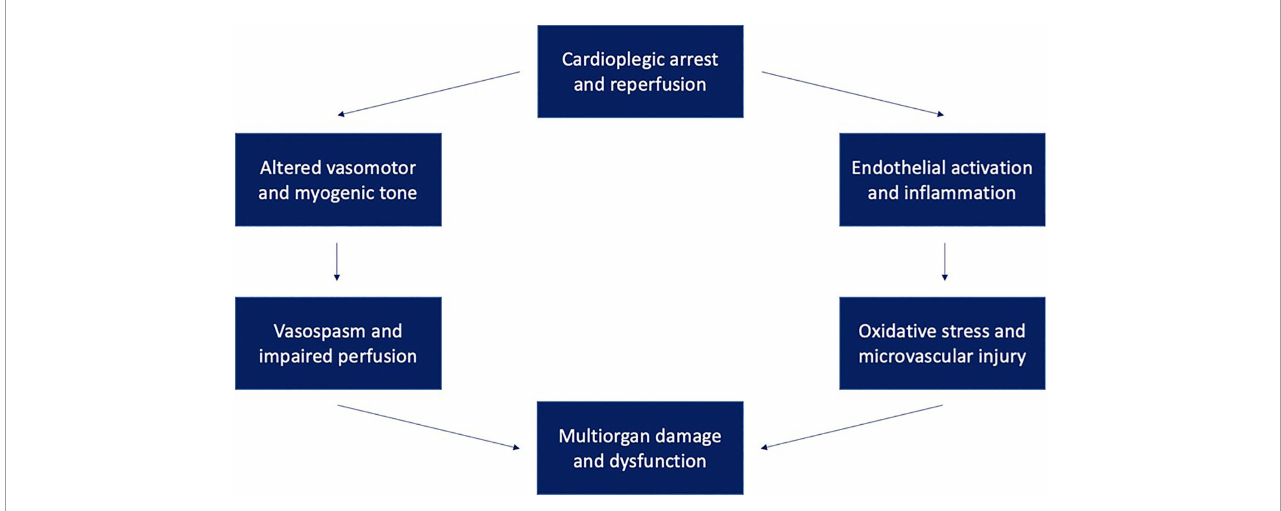
FIGURE1 Ischemia-reperfusion injury following cardioplegic arrest may lead to multisystem dysfunction through multiple mechanisms. These mechanisms include endothelial activation and inflammation leading to oxidative stress and altered vasomotor and myogenic tone leading to vasospasm and organ